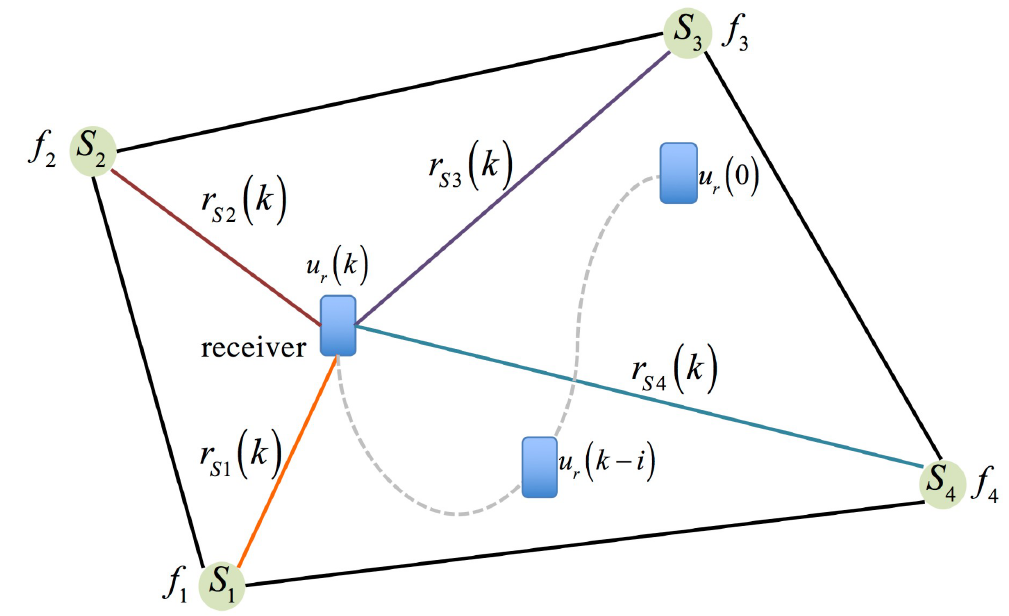
Figure 2. Geometric relationship between the carried receivers with respect to tagged sound sources.